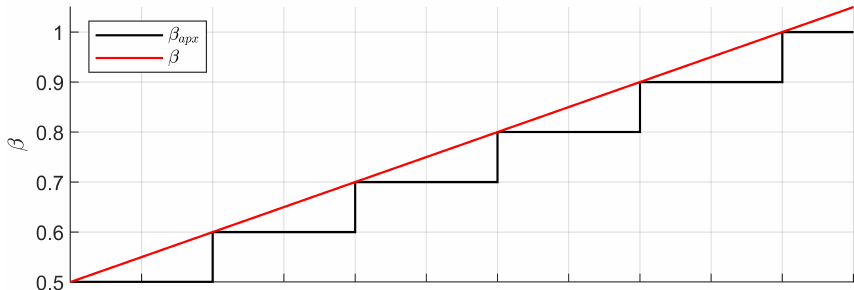
Figure 2. Visualization of β